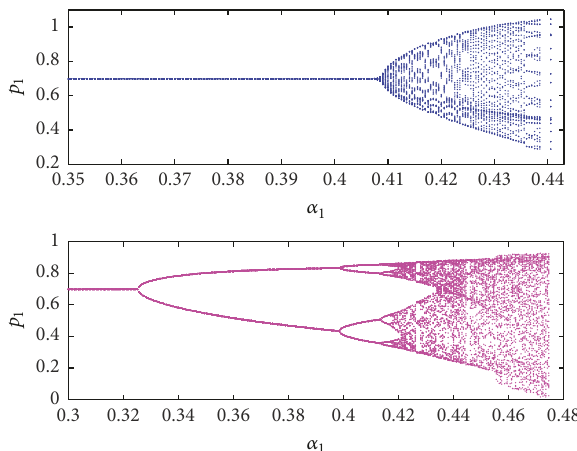
Figure 4: The bifurcation diagram of 𝑝 1 with respect to 𝛼 1 when 𝜃 = 0.6 , 𝛼 2 = 0.01 , and 𝛼 = 0 , where 𝑤 𝑖 = 0.5 in the first figure and 𝑤 𝑖 = 0.8 in the second